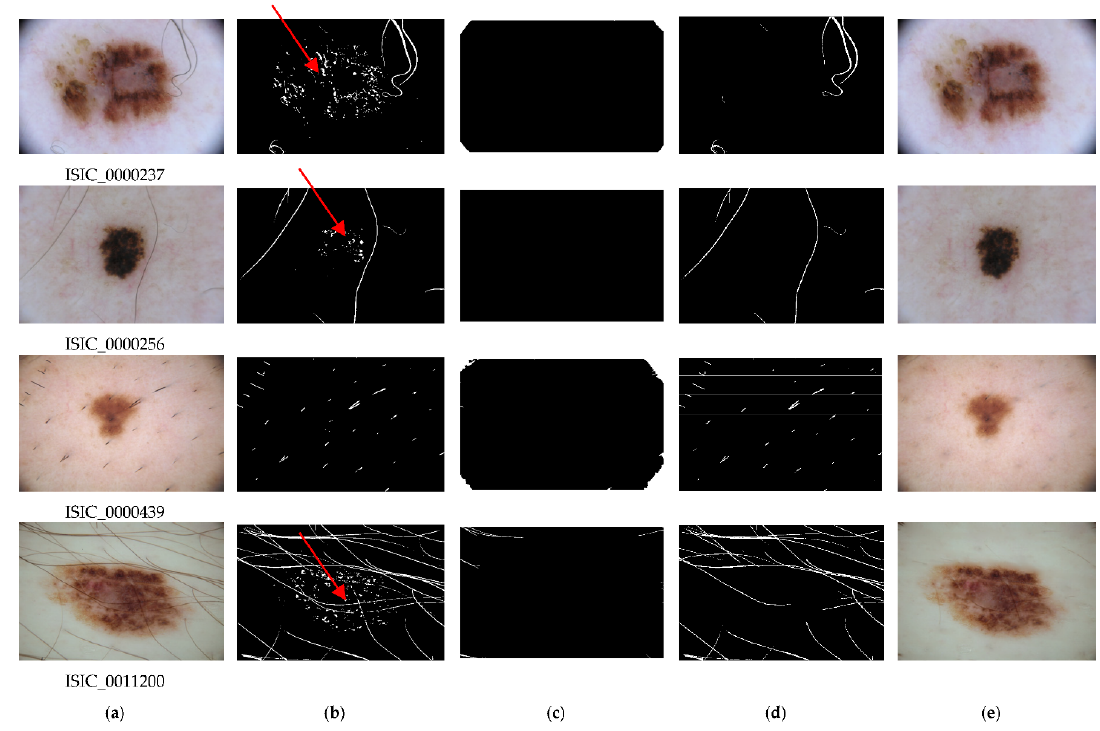
Figure 3. Some examples of results obtained in the main steps of HR-SSC: ( a ) input image; ( b ) detected pseudo-hair components; ( c ) border/corner components; ( d ) detected hair; ( e ) resulting